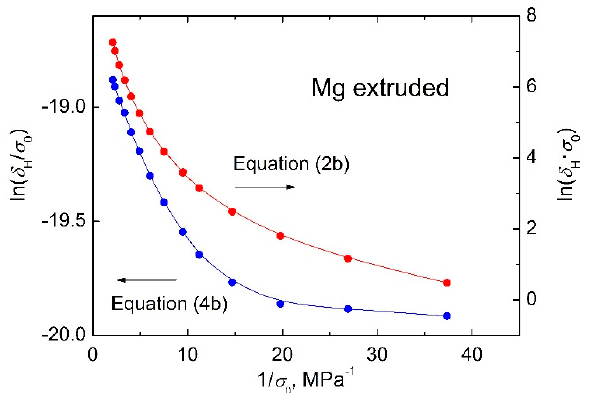
Figure 7. Failed attempts to linearize experimental data using Equation (2b) (right-hand axis) and Equation (4b) (left-hand axis). It can be seen that Equations (2b) and (4b) do not lead to a straightening of the experimental dependences in the coordinates proposed.